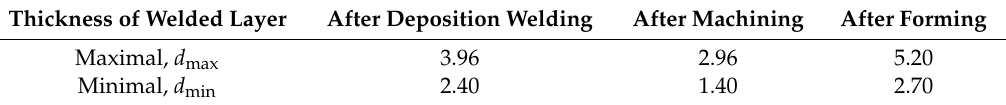
Figure 5. Macrographs of the joining zone in longitudinal section ( a ) in a deposition-welded workpiece and ( b ) in a forged bevel gear at the middle of the tooth tip. Table 4. Process parameters of the forging process.